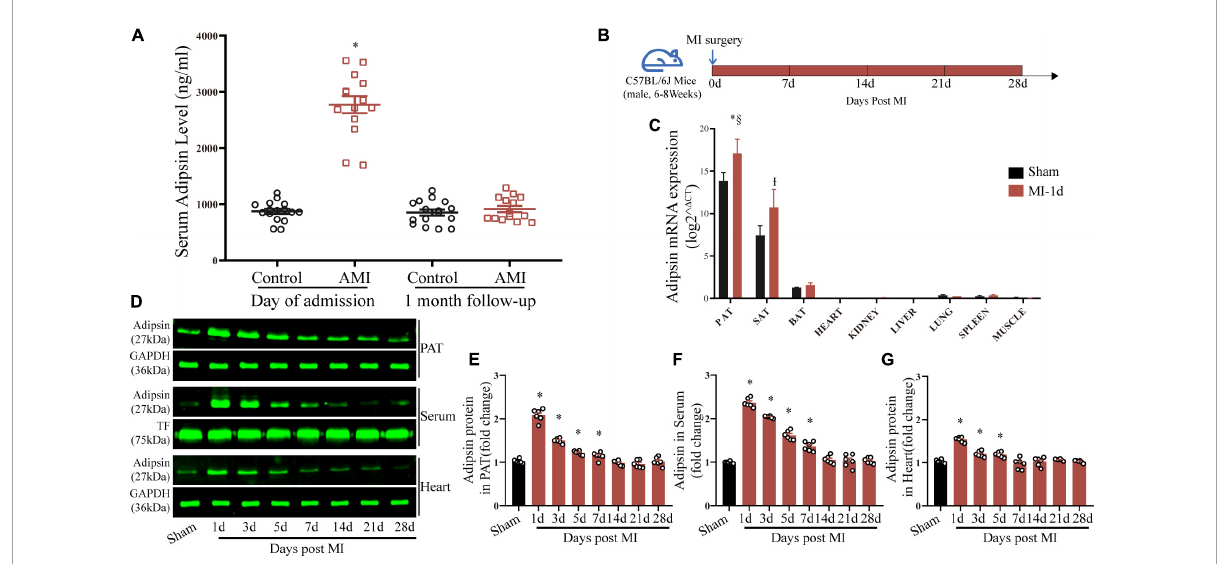
FIGURE1 Acute myocardial infarction evokes Adipsin production and secretion. (A) Serum Adipsin levels at admission and 1 month after discharge in MI patients. n = 16 and 14, * p < 0.05 vs. Control group. (B) Schematic illustration of animal experimental procedures analyzing Adipsin production and secretion. (C) Adipsin mRNA expression determined in pericardial adipose tissue (PAT), subcutaneous adipose tissue (SAT), brown adipose tissue (BAT) and other organs using RT-qPCR. n = 6, * p < 0.05 vs. Sham group (PAT), I p < 0.05 vs. Sham group (SAT), § p < 0.05 vs. MI group (SAT). (D–G) Adipsin protein levels of pericardial adipose tissue (PAT), serum and heart tissues determined using Western blots. n = 6 (sham) and 42 (MI). * p < 0.05 vs. Sham group. For (A,C,E,F,G) , statistical analysis was performed using one-way